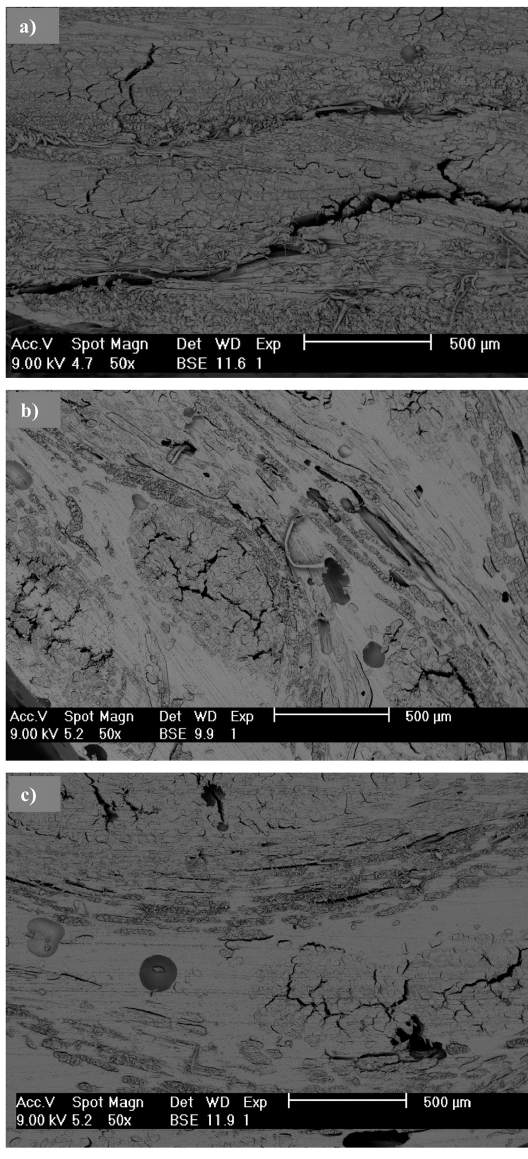
Figure 7. Cross section observations by SEM.